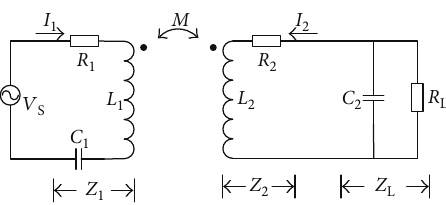
Figure 1: Equivalent circuit for series-parallel compensated WPT